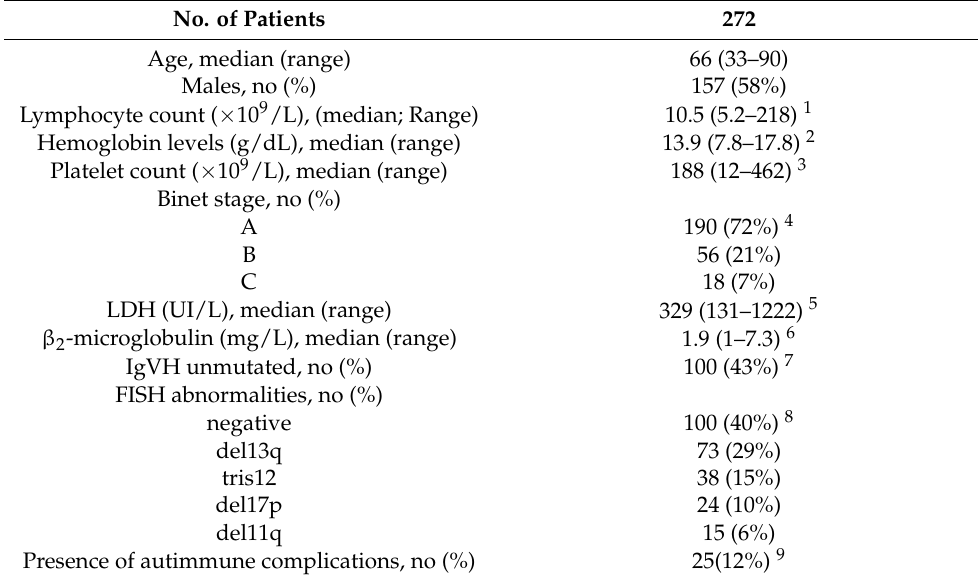
Table 1. Clinical and laboratory features of CLL patients at study entry.